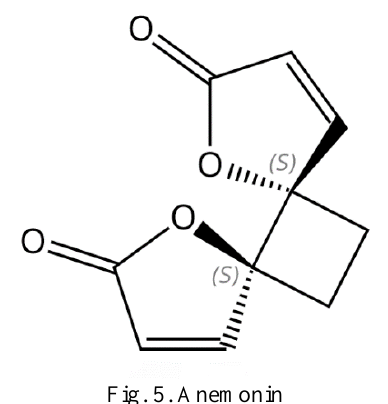
Pharmacological action and use in